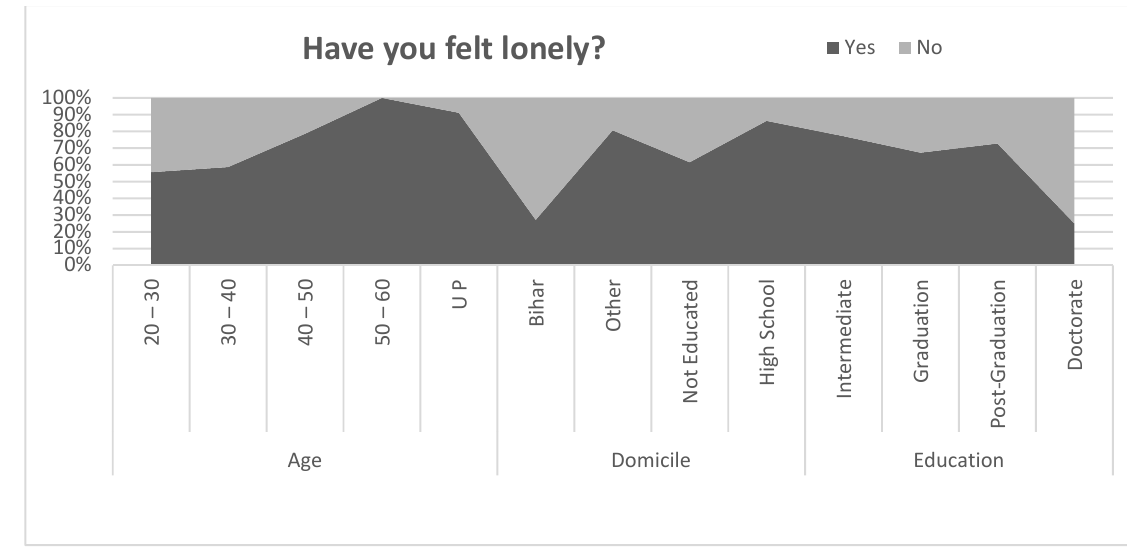
Figure 5. Comparison of feeling lonely.